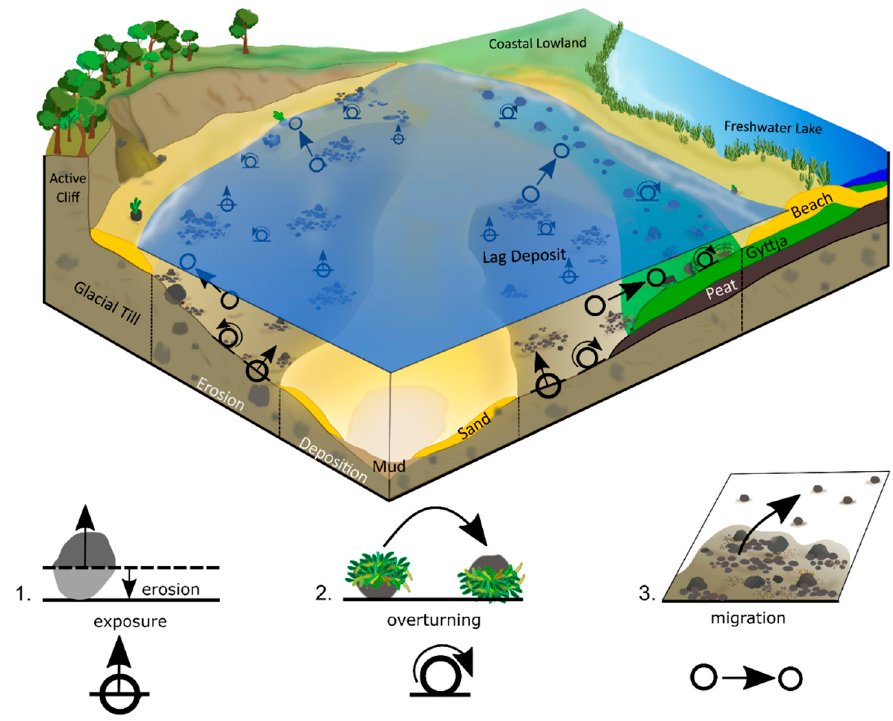
Figure 6. Conceptual model of the dynamics of stone habitats. 1. Exposure of “new” cobbles and boulders from the glacial till by abrasion. 2. Overturning of cobbles and boulders creating empty hard ground for organisms to settle. 3. Migration of cobbles and boulders out of the autochthonous habitat (lag sediments), creating a new allochthonous habitat or expanding the existing habitat.